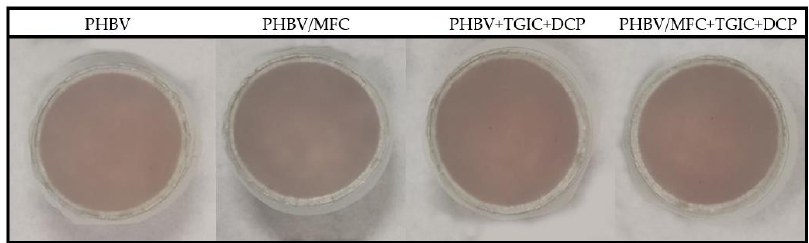
Figure 1. Images of the minced pork meat samples packaged in trays with the green composite lid films of poly(3-hydroxybutyrate- co -3-hydroxyvalerate) (PHBV) with microfibrillated cellulose (MFC) and compatibilized with triglycidyl isocyanurate (TGIC) and dicumyl peroxide (DCP).